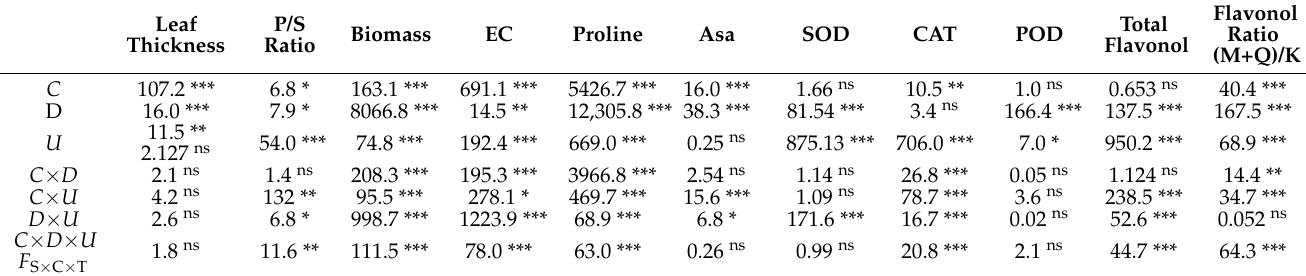
Table 1. F-values and significance levels for three-way ANOVAs of the effect of cultivar, drought, UV-B, and their interaction on growth and physiological properties in Chestnut rose. C, cultivar; D, drought; U, UV-B. P/S ratio, leaf palisade/spongy tissue ratio; EC, leaf electrolyte conductance; Asa, leaf total ascorbic acid concentration. ns, not significant. Figure 1. Leaf thickness ( A ), leaf palisade/spongy tissue ratio ( B ) and plant above ‐ ground biomass ( C ) of two Chestnut rose cultivars under different water regimes and solar UV ‐ B treatments. Values are mean ± SD. Different letters above the bars indicate a significant difference between treatments at p < 0.05 level by LSD pairwise comparisons. Control, ambient UV ‐ B; –UV ‐ B, UV ‐ B exclusion; D, drought with ambient UV ‐ B; –UV ‐ B+D, drought with UV ‐ B exclusion.